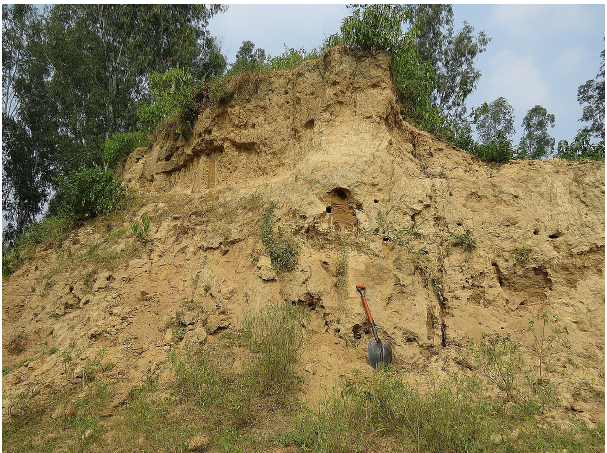
Figure A15. RLB – ∼ 42m above modern channel on roadside cut. Poorly sorted, structureless fluvial conglomerate. Large, rounded boulders, cobbles and sands (Ray and Srivastava, 2010); 90mm long penknife for scale.